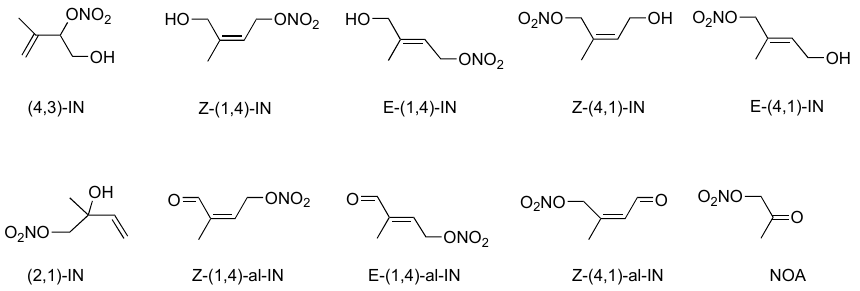
Figure 1. Isoprene-derived nitrates investigated in the CASMIN project. The labelling scheme for hydroxy nitrates is the same as that of Lockwood et al. (2010) and for the aldehydes as described in the text. NOA is acetone